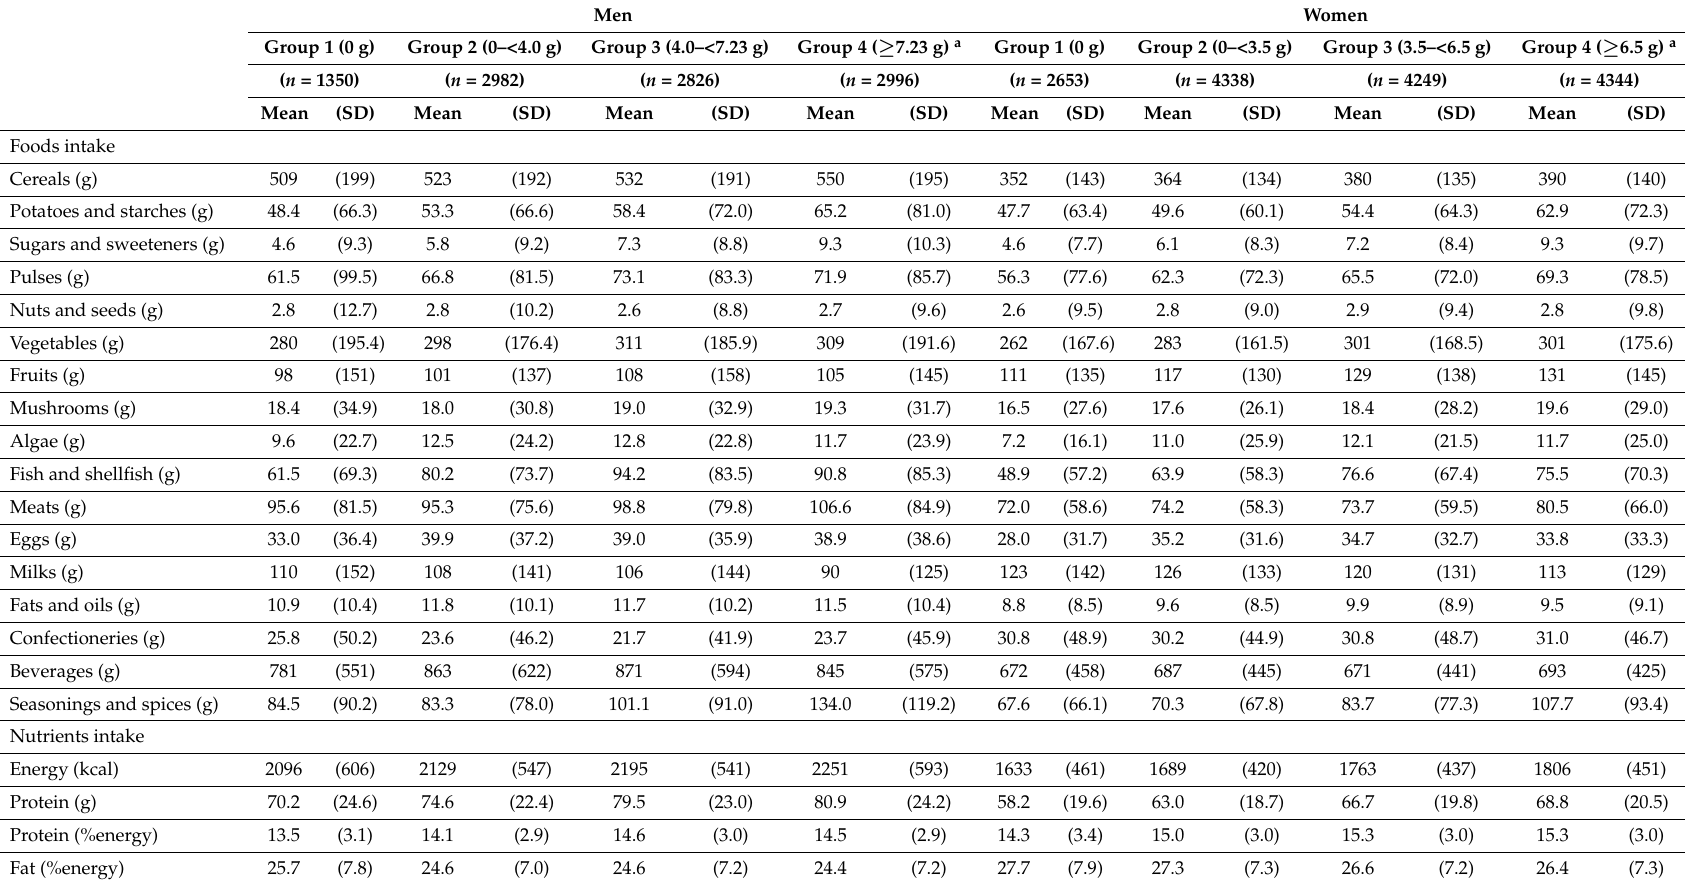
Table 3. Characteristics of the dietary intakes of the participants according to the portion size of soy